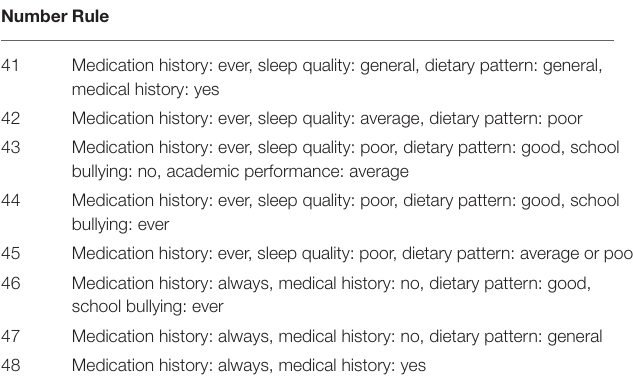
TABLE 8 | Psychological crisis judgment Table 5